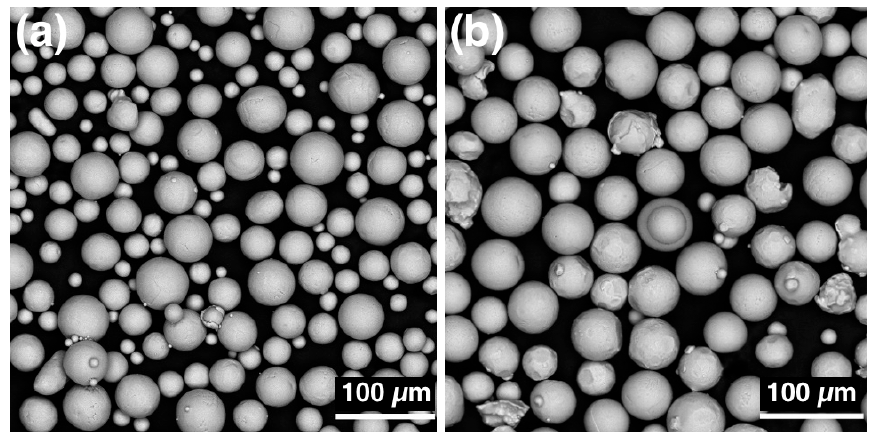
Figure 1. Scanning electron microscope (SEM)-images of ( a ) Ti and ( b ) Ti64 powders. The samples were fabricated using the SLM Solutions 280HL machine (Lübeck, Ger- many) in an argon atmosphere (99.99% purity) on a Ti64 built substrate. For microstruc- tural characterization and microhardness evaluation, the samples of 20 mm height